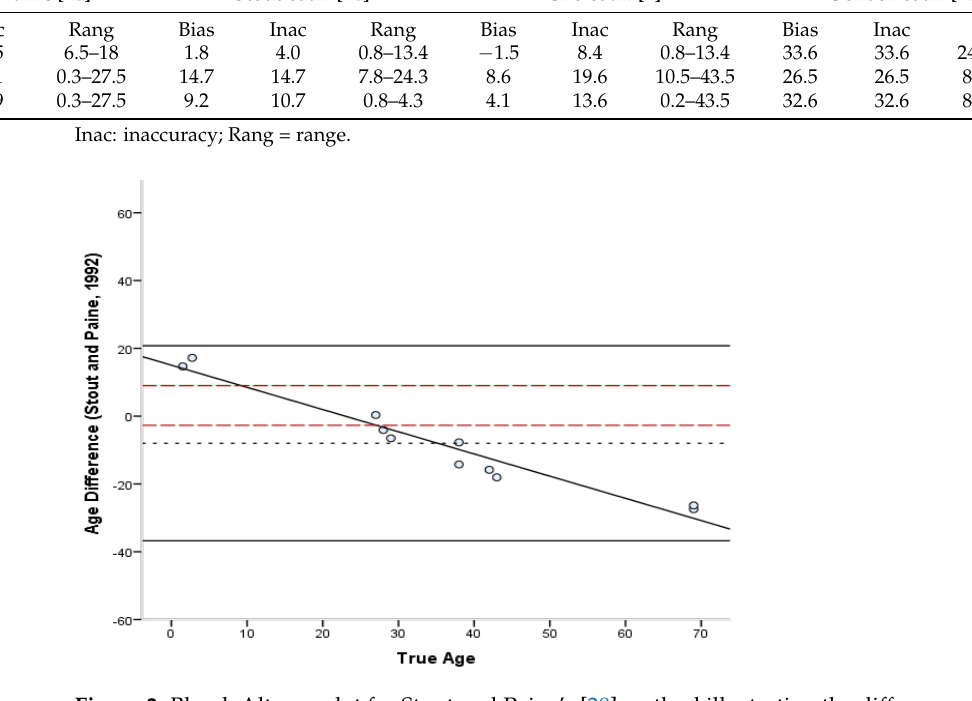
Figure 3. Bland –Altman plot for Stout’s et al. [26] method illustrating the differences between known and estimated ages for the ribs against the known age. Depicted are 95% limits of agreement (black horizontal lines), mean difference/bias (black dotted line), best fit lines and 95% confidence intervals of the SEE for each method (dashed lines). R 2 of the best fit line: 0.160.